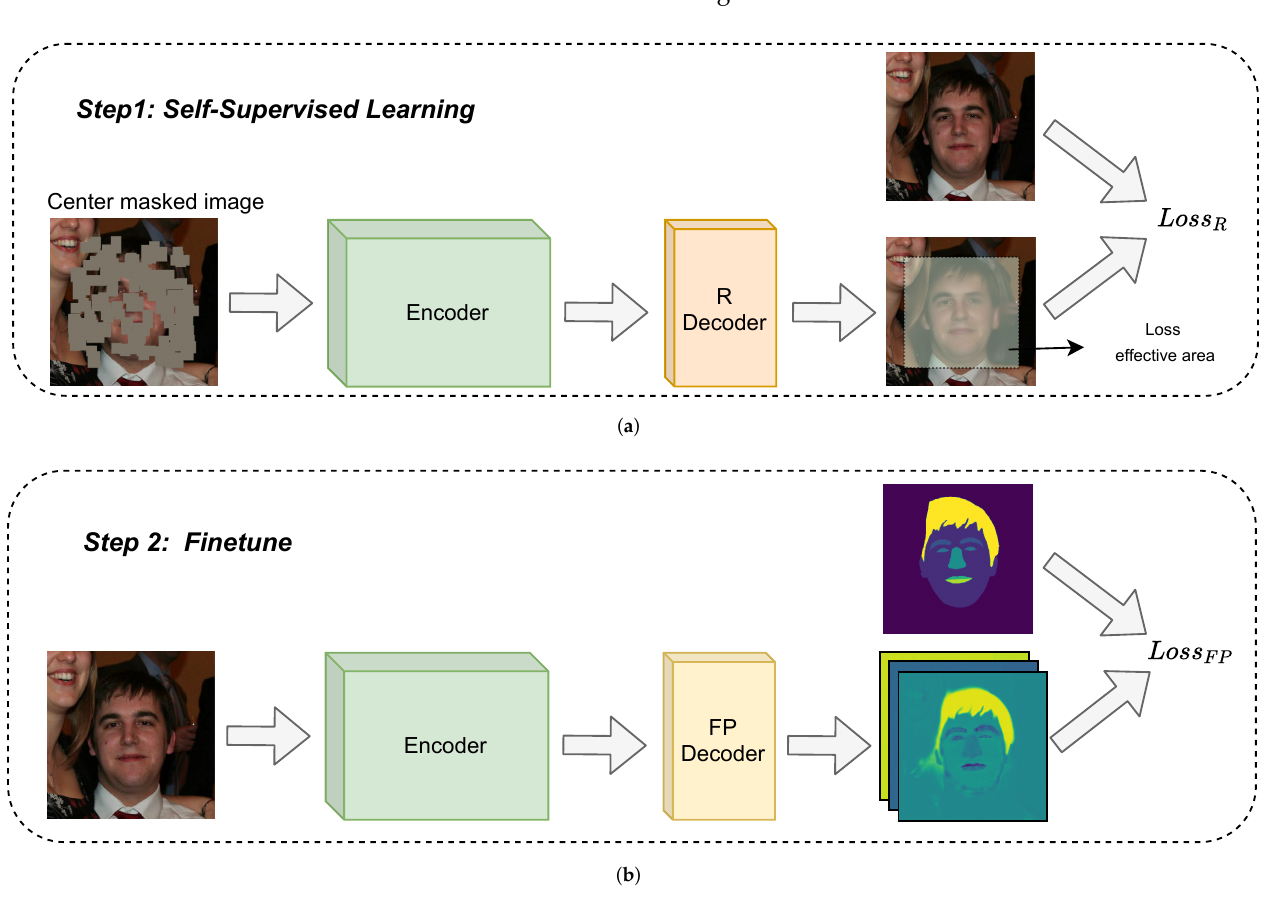
Figure 1. The overall framework of our approach. We build our encoder followed the UNet++ and share the same in two stages. ( a ) Step 1: Masked self-supervised pretraining. ( b ) Step 2: Fine-tune models on the target